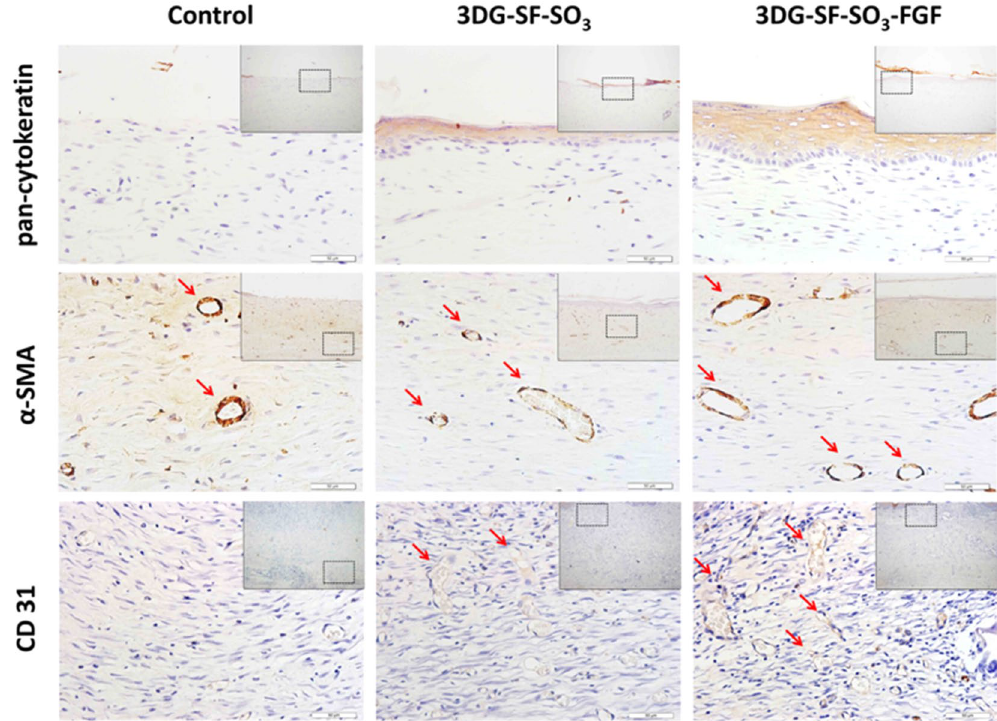
Figure 8. Epidermis and blood vessel formation in skin defects. Immunohistochemical staining of wound sections to detect expression of cytokeratin, SMA and CD31, after implantation with 3DG-SF-SO 3 and 3DG-SF- SO 3 -FGF scaffolds at day 28 post-surgery. Scale bars = 50 μ